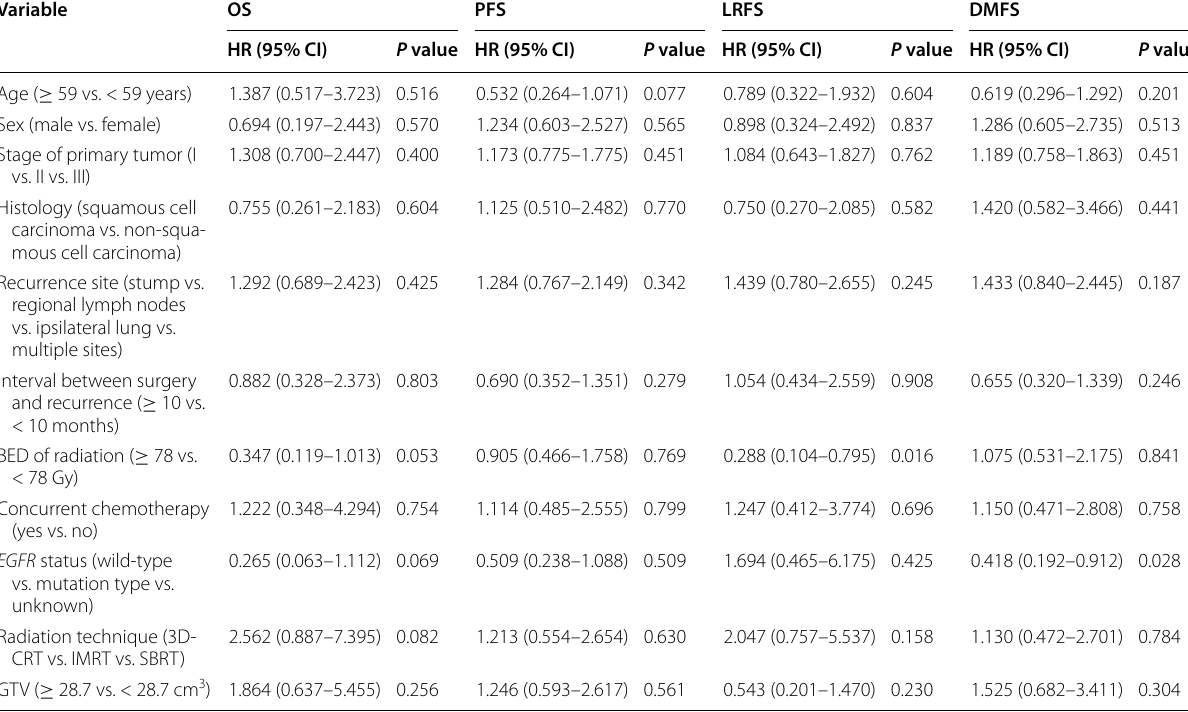
Table 2 Univariate analyses of prognostic factors for 74 NSCLC patients with postoperative locoregional recurrence treated with radical radiotherapy